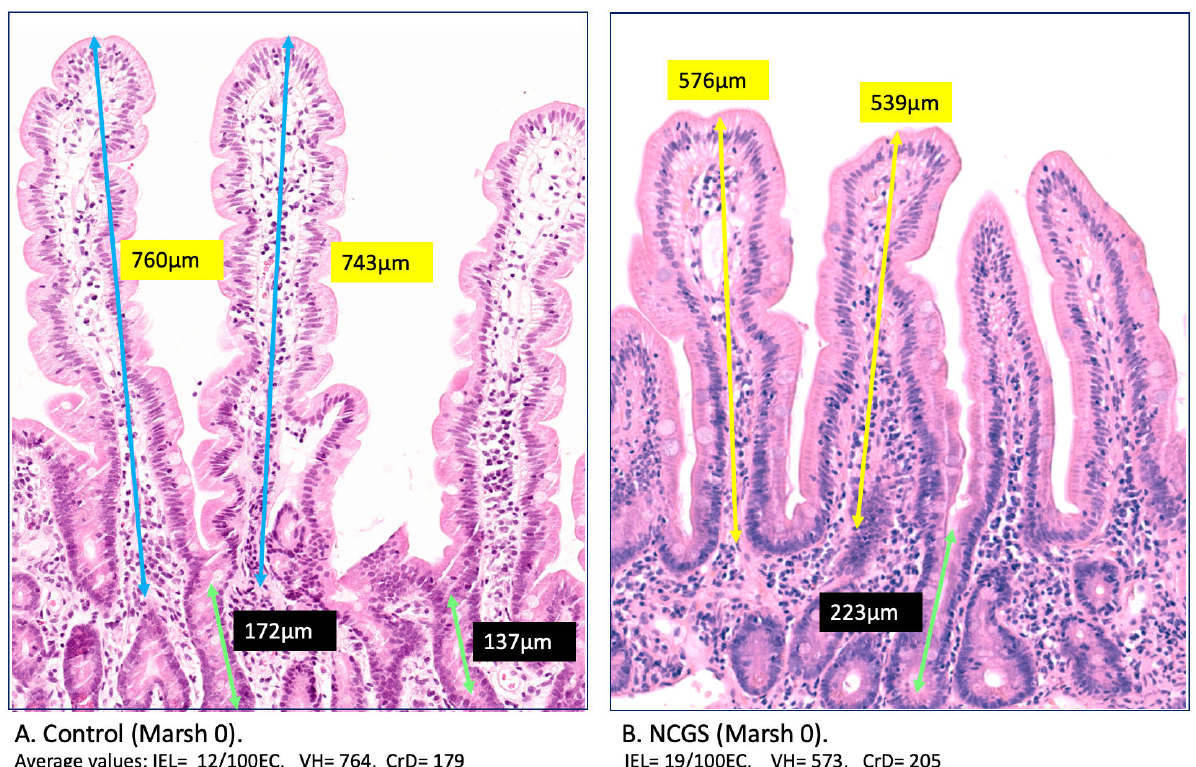
Figure 5. Architectural distortion at Marsh 0 stage. The measurable subtle changes that have been considered as a component of the spectrum of normal mucosa represent a considerable part of architectural distortion signifying the NCGS phenotype ( B ). This reflects in VH, VH/CrD ratio, and the IEL infiltration that were significantly different in NCGS Marsh 0 ( B ) compared to healthy control ( A